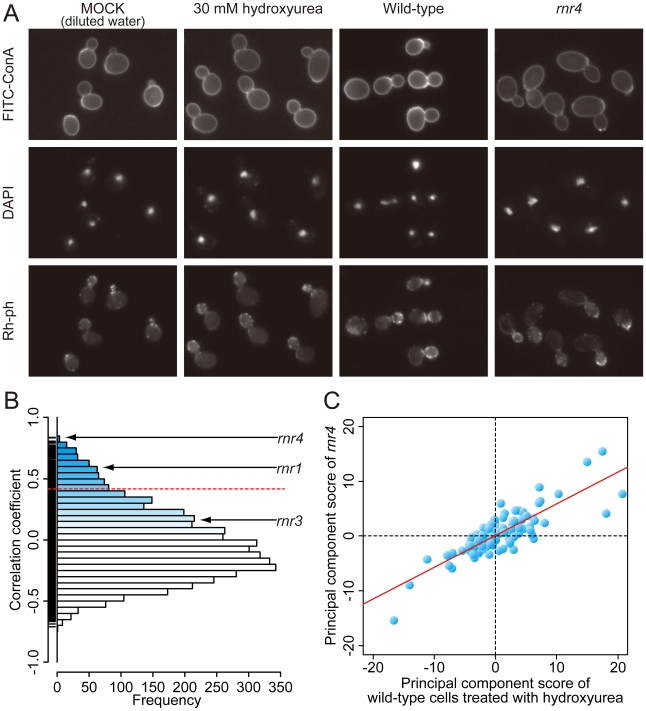
Hydroxyurea treatment and the results of target inference.A) Photographs of wild-type cells treated with 30 mM hydroxyurea and the rnr4 mutant. Cells were triply stained with FITC-ConA, Rh-ph, and DAPI. Quantitative analysis of the hydroxyurea-induced morphologic changes is summarized in Table S1. B) A histogram of correlation coefficients (R) between the mutant and hydroxyurea-treated wild-type cells. The dashed red line indicates the position of the R value corresponding to the two sided P value of 0.05 with the Bonferroni correction based on a correlation coefficient test. C) Two-dimensional plot of wild-type cells treated with hydroxyurea and the rnr4 mutant. The scores for the 104 principal components are plotted. The red line indicates a linear regression model (R  = 0.738).